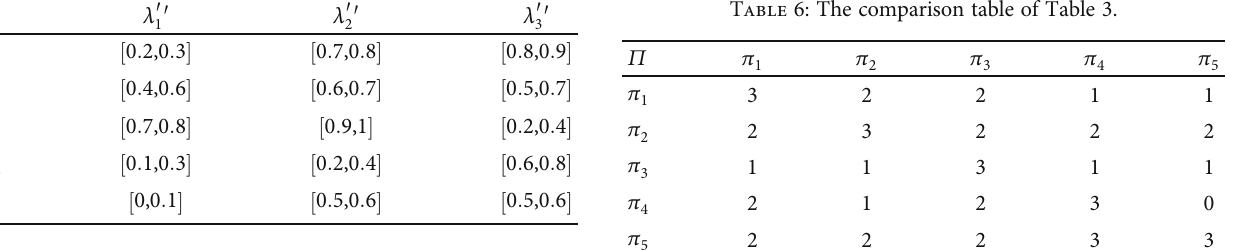
Table 6: The comparison table of Table 3.